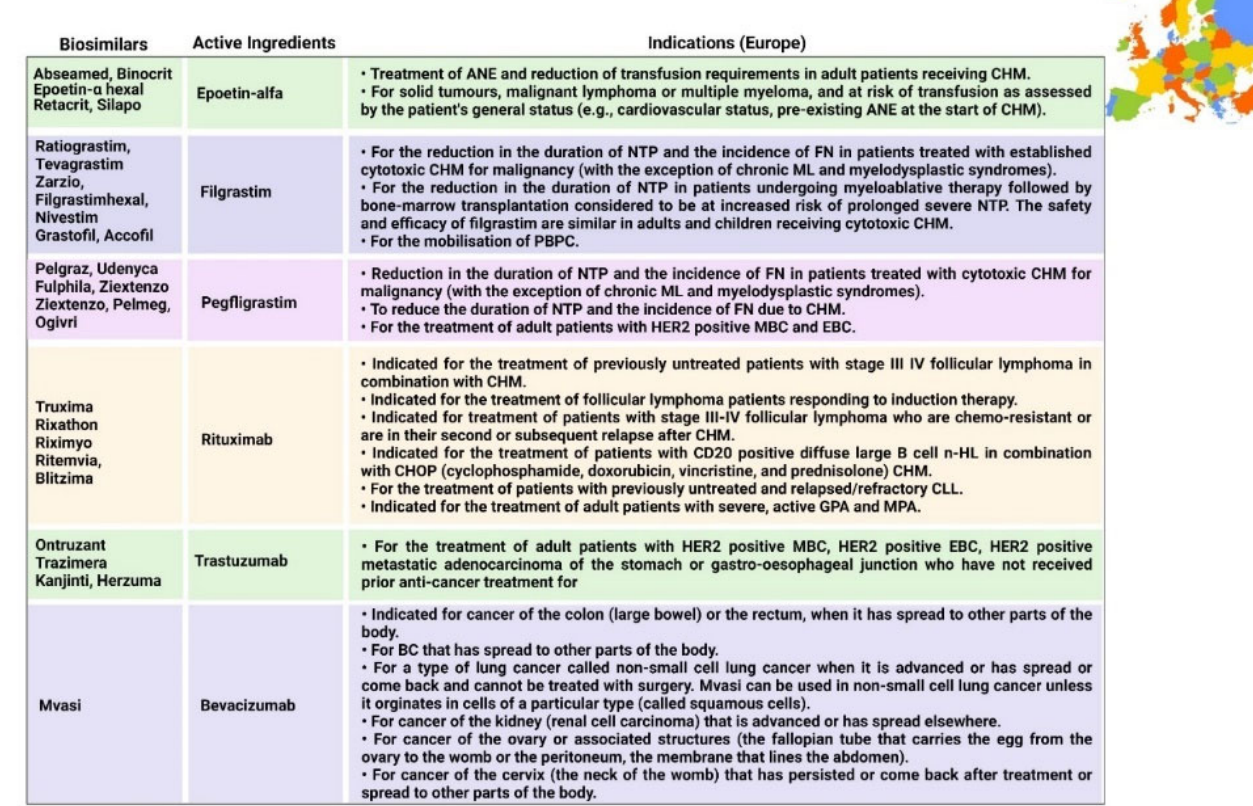
Figure 5. Indications approved in Europe for biosimilars [93,94,95,96,97,98,99,100,101,102,103,104,105,106,107,108,109,110,111,112,113,114,115,116,117,118]. ANE = anemia; CHM = chemotherapy; CHOP = cyclophosphamide, doxorubicin hydrochloride (hydroxydaunorubicin), vincristine sulfate (Oncovin), and prednisone; CLL = chronic lymphocytic leukemia; EBC = early breast cancer; FN = febrile neutropenia; GPA = granulomatosis with polyangiitis; HER2 = human epidermal growth factor receptor 2; MBC = metastatic breast cancer; ML = myeloid leukemia; MPA = microscopic polyangiitis; PBPC = peripheral blood progenitor cell; n ‐ HL = non ‐ Hodgkin lymphoma; NTP = neutropenia.